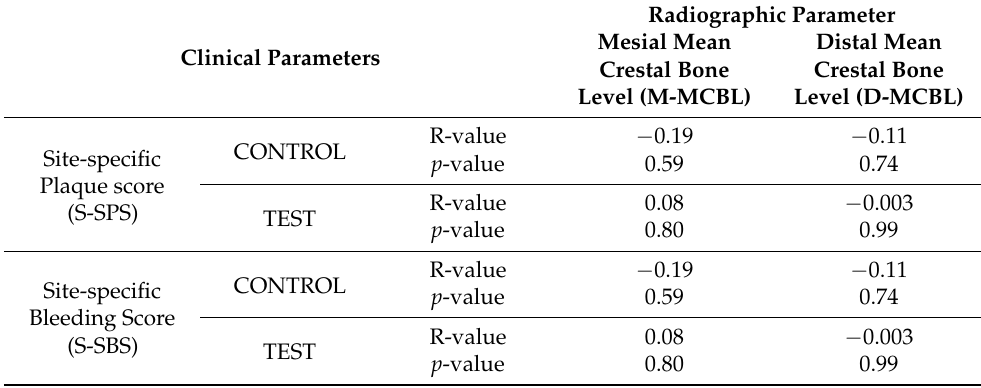
Table 4. Pearson’s correlation of clinical and radiographic parameters at one year in the control and test